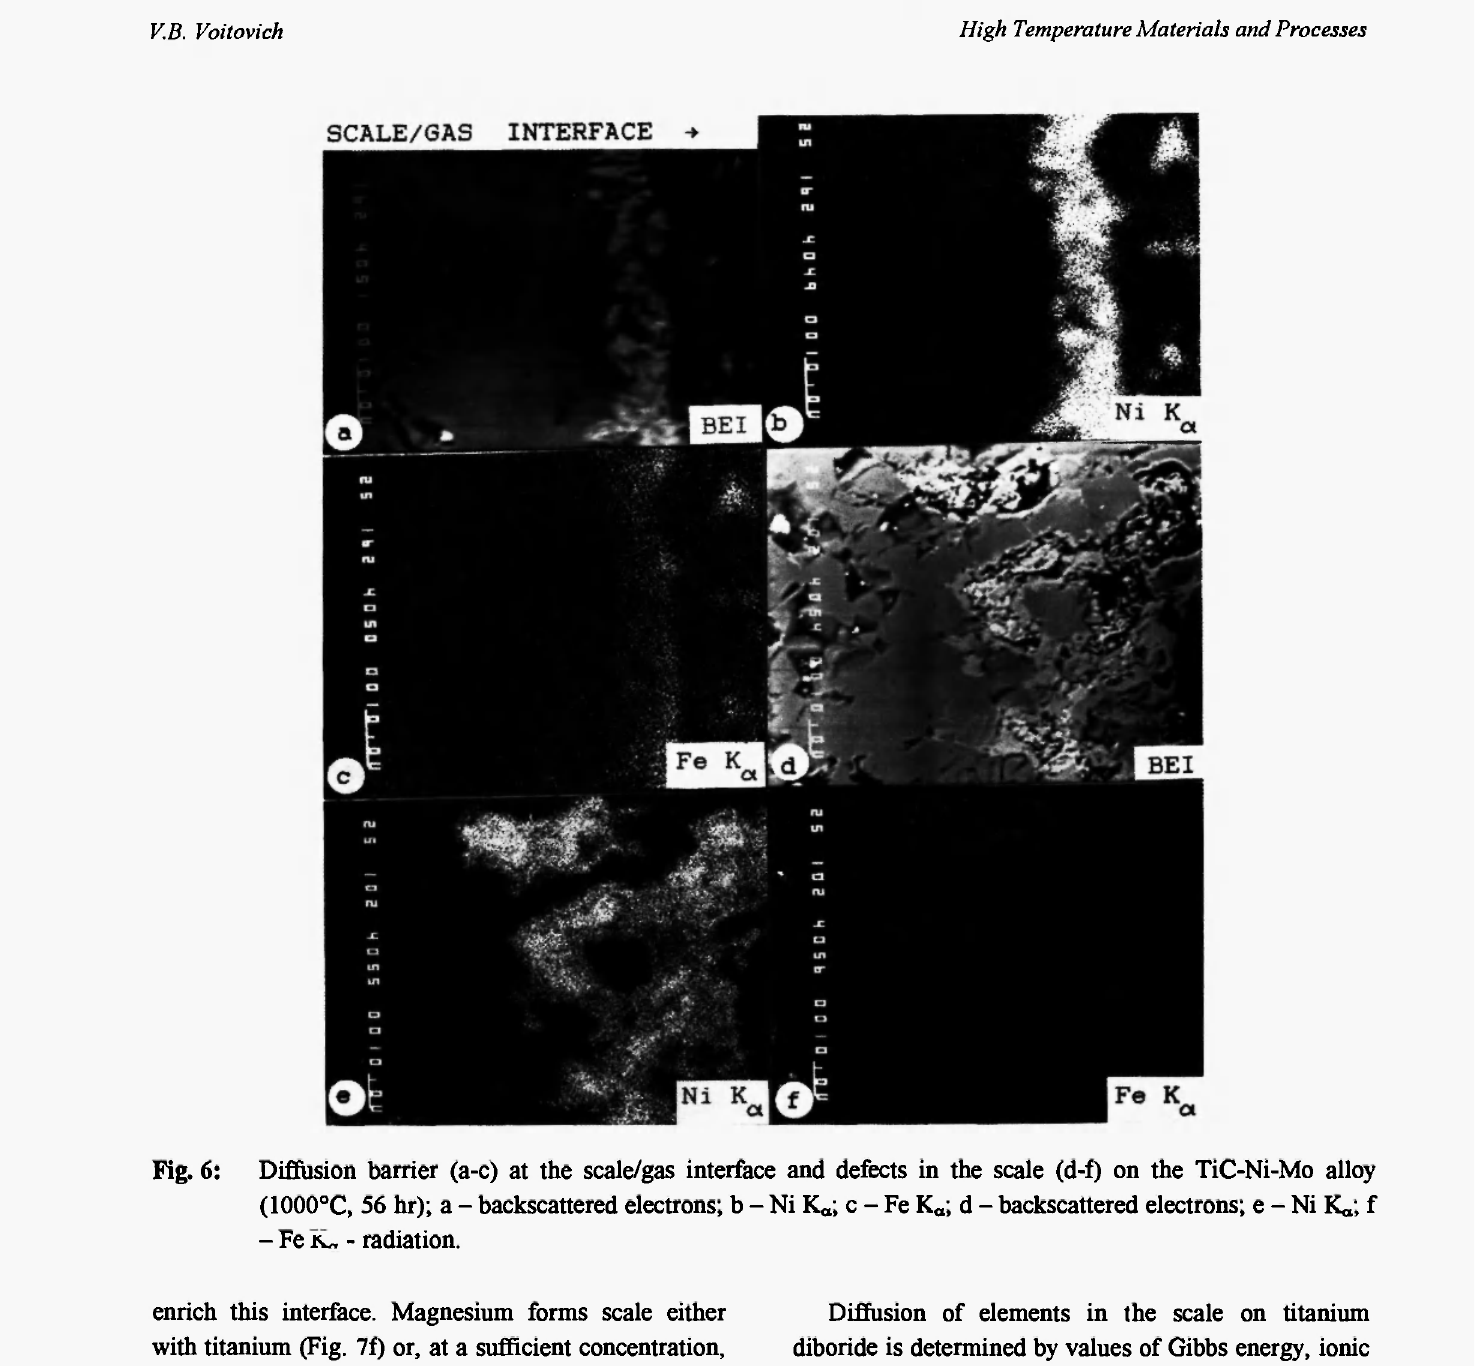
Fig. 6: Difiiision barrier (a-c) at the scale/gas interface and defects in the scale (d-f) on the TiC-Ni-Mo alloy (1000°C, 56 hr); a - backscattered electrons; b - Ni K«; c - Fe K«; d - backscattered electrons; e - Ni K«; f - Fe -